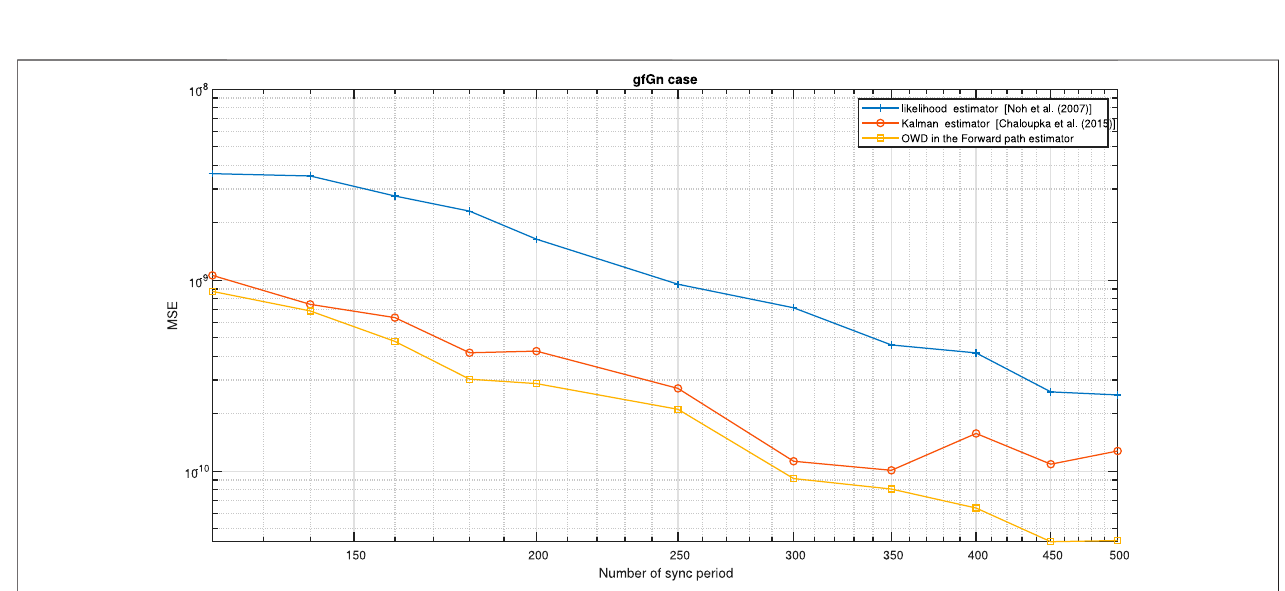
FIGURE11| Performance (MSE) comparison betweentheOWDclockskewestimator for theForward path ( Eq.61 ),likelihood clockskew estimator proposed by Nohetal.[5]andKalmanclockskewestimatorproposedbyChaloupkaetal.[6].ThePDVisangfGnprocess. α =50 ppm , Q =5 ms , T syn (cid:2) 15 . 6 ms ( 64 packet (cid:2) 4 e − 8 [ sec 2 ] , σ 2 (cid:2) 1 . 3 e − 7 [ sec 2 ] , L = 100, Q δ σ = δ μ = 1 e − 4, ^ μ [ 1 ] (cid:2) 0. The results were obtained for 100 Monte- a = 0.08, d ms = 5.5 ms , d sm = 5 ms , σ 2 ω ω 2 KAL = 0, 1 Carlo trails.